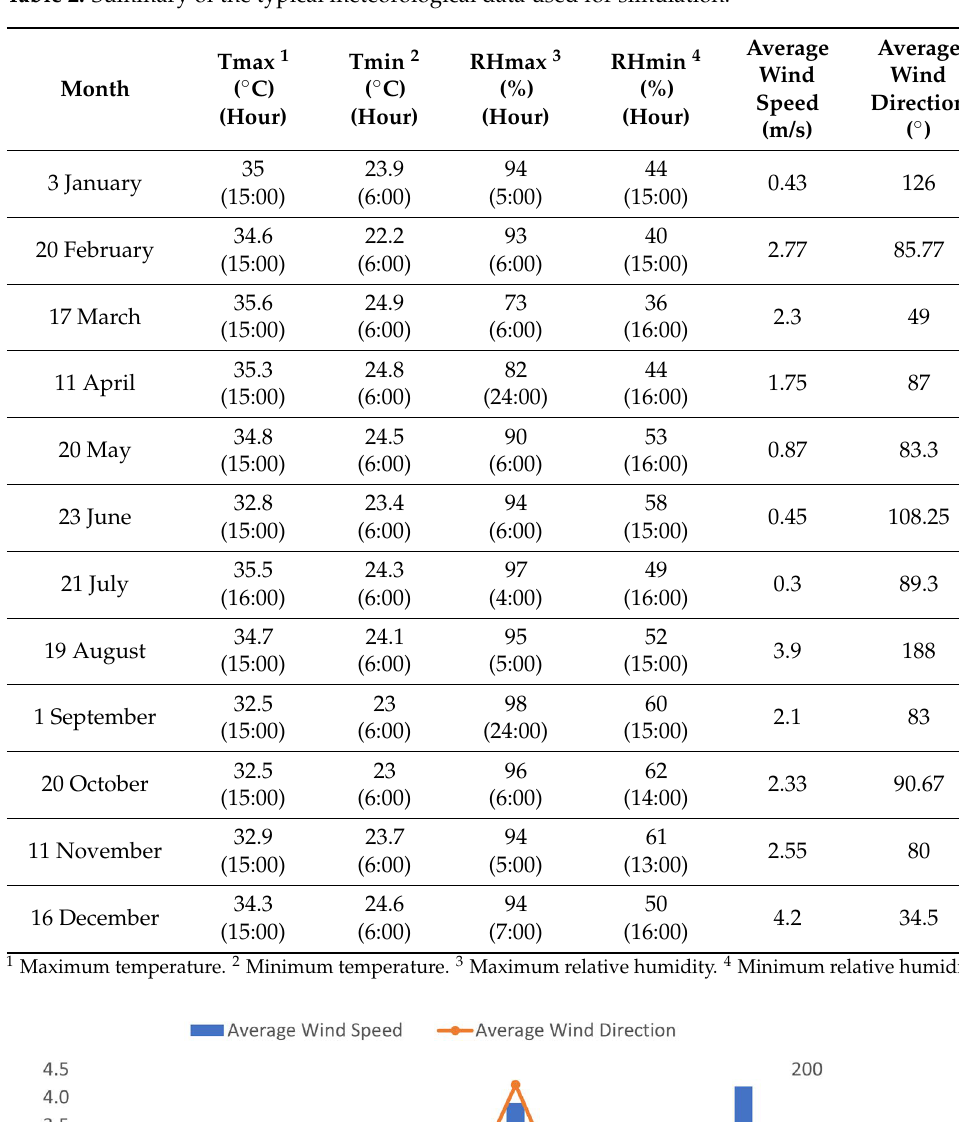
Table 2. Summary of the typical meteorological data used for simulation.